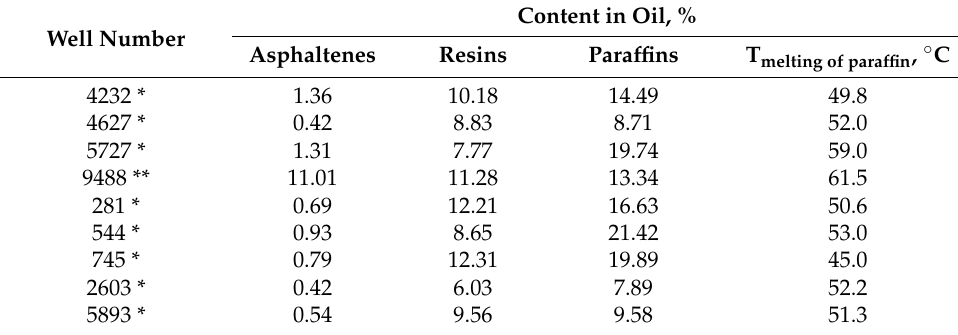
Table 1. Compositions of the studied